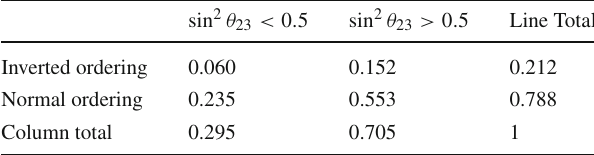
32 Fig. 75 Two-dimensional histograms of the marginal posterior prob- ability with a 90% (1 σ ) credible interval given by the white solid (dashed) lines [62]. The one-dimensional histograms represent the pos- terior probability density where all other parameters are marginalized. The blue areas are the 1 σ (dark), 90% (medium), and 95% (light) cred- ible intervals Table 19 Posterior probabilities for the mass orderings and sin 2 θ